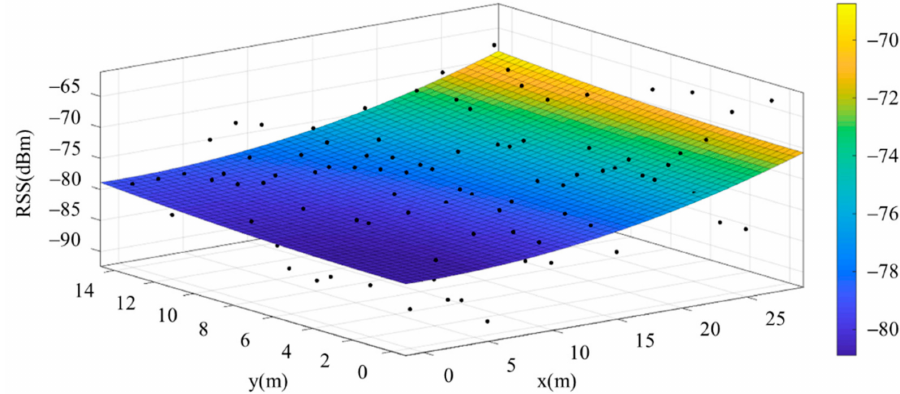
Figure 13. Fitting Model Generated for Base Station B.